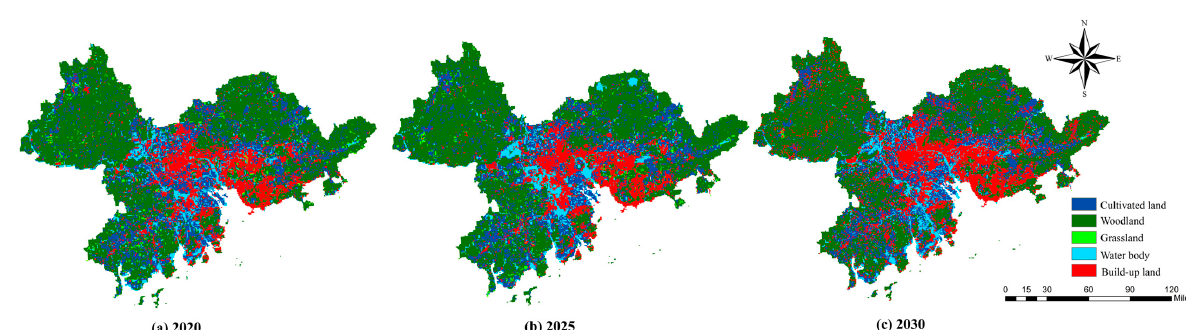
Figure 6. Land-use change for Pearl River Delta from 2020 to 2030.